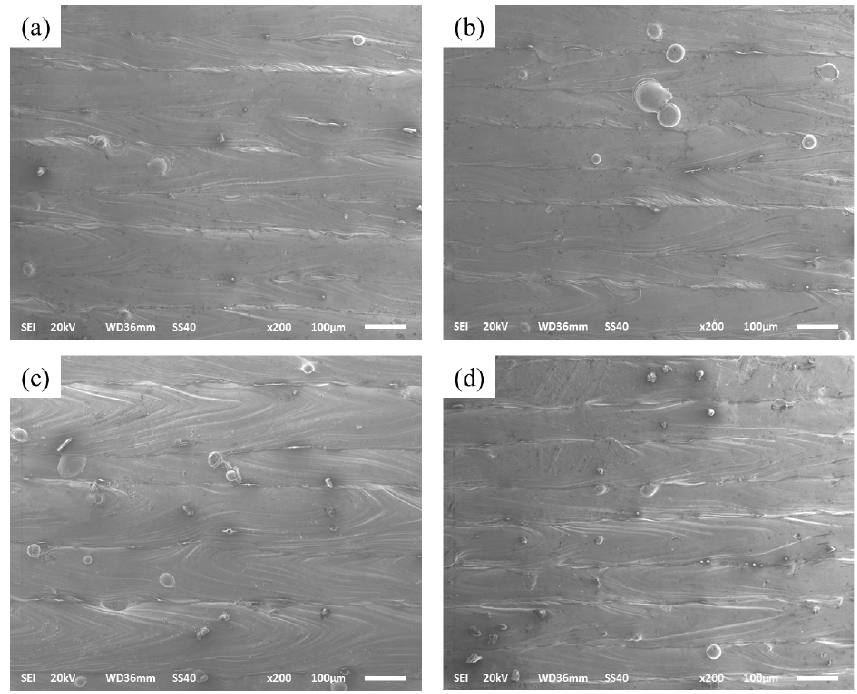
Figure 9. Micrographs showing spheroidization of ( a ) 80 μ s; ( b ) 120 μ s; ( c ) 160 μ s; and ( d ) 200 μ s.